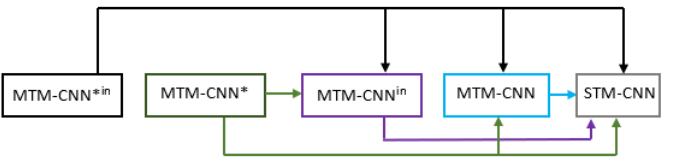
Figure 8. Graphical representation of the Friedman test for the MTM-CNN. Models were drawn according to their ranks starting with the best model from left to